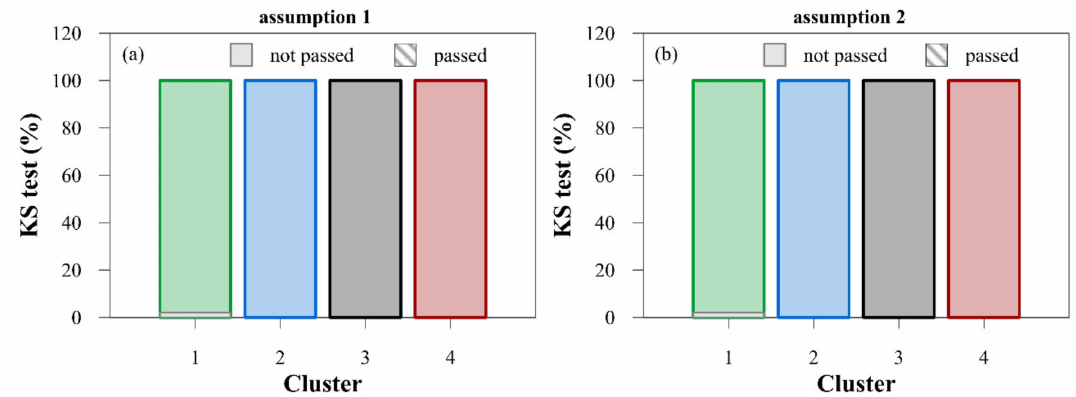
Figure 8. Percentage of samples passing / not passing the Kolmogorov-Smirnov test for the four tested Clusters under ( a ) assumption 1 and ( b ) assumption 2 for the underlying normal distribution of sample means.